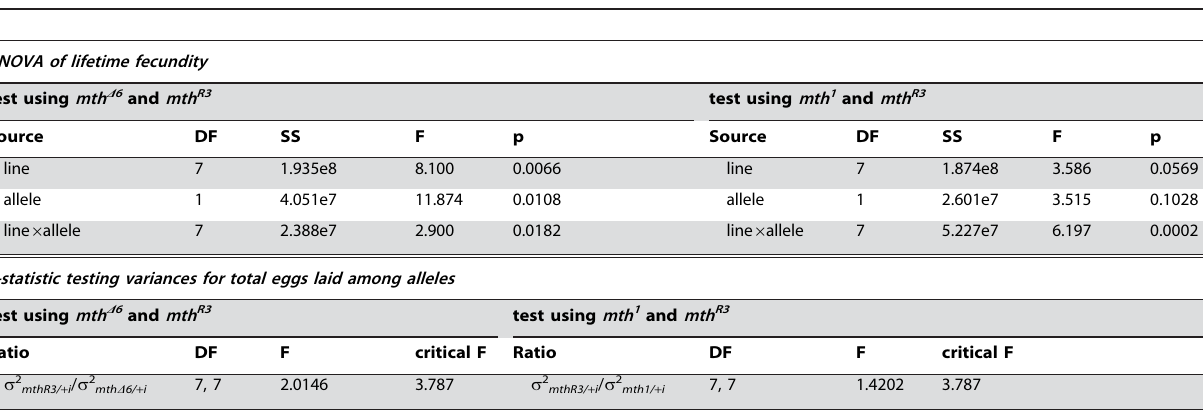
Table 2. Statistical results for the fecundity